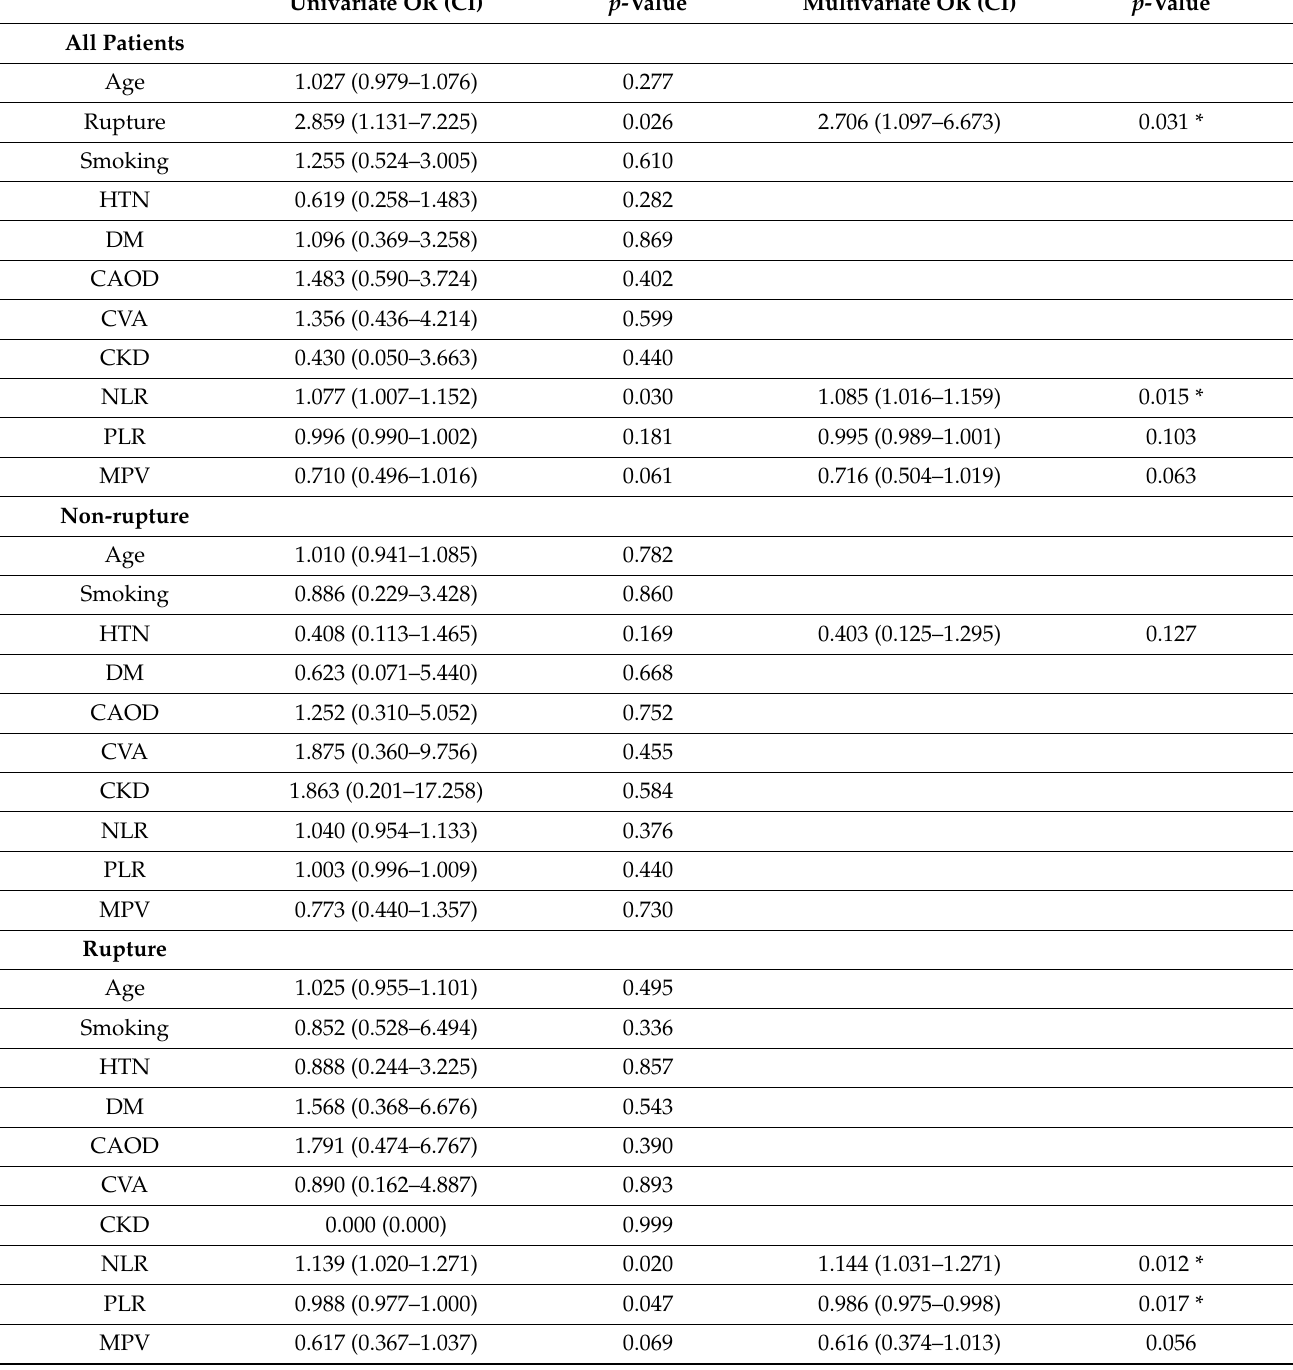
Table 4. Logistic regression analysis for the predictors of 1-year mortality after AAA open